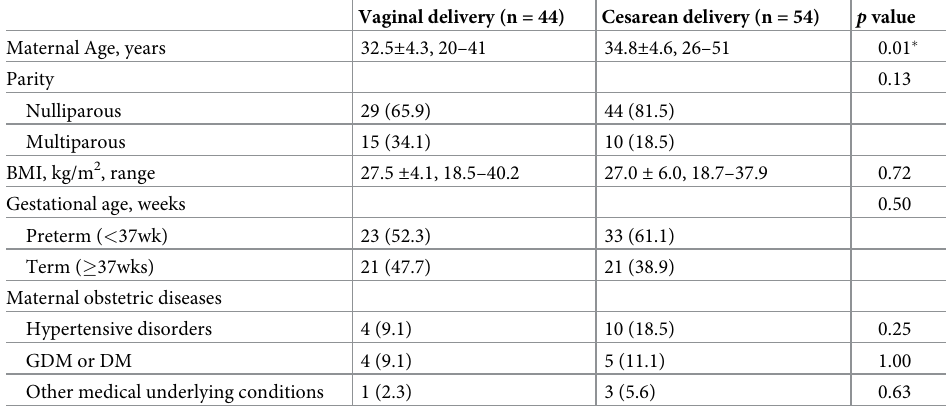
Table 1. Clinical characteristics of the